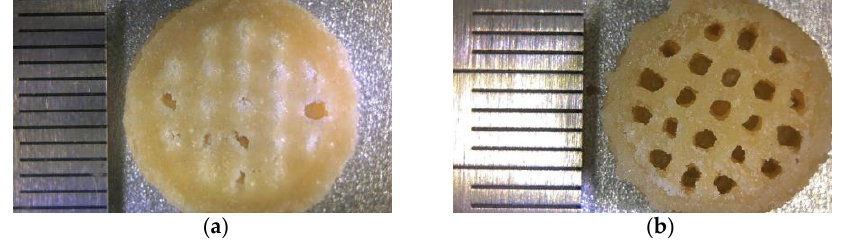
Figure 10. The laser-sintered scaffold of 10%-CPLA: ( a ) under best process parameters; ( b ) via thermal post-processing along with low laser-energy